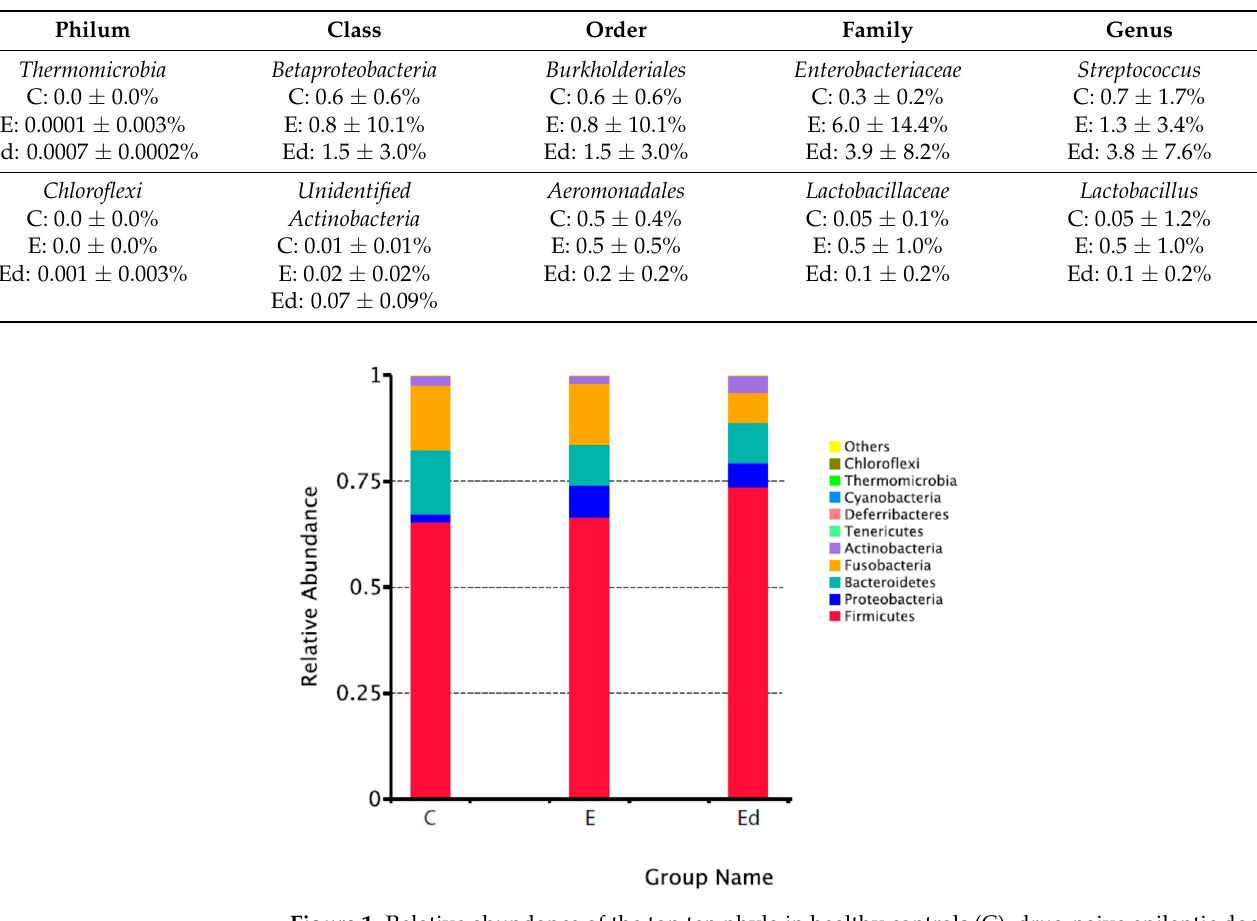
Figure 1. Relative abundance of the top ten phyla in healthy controls (C), drug-naive epileptic dogs (E) and treated epileptic dogs with an AED (Ed).